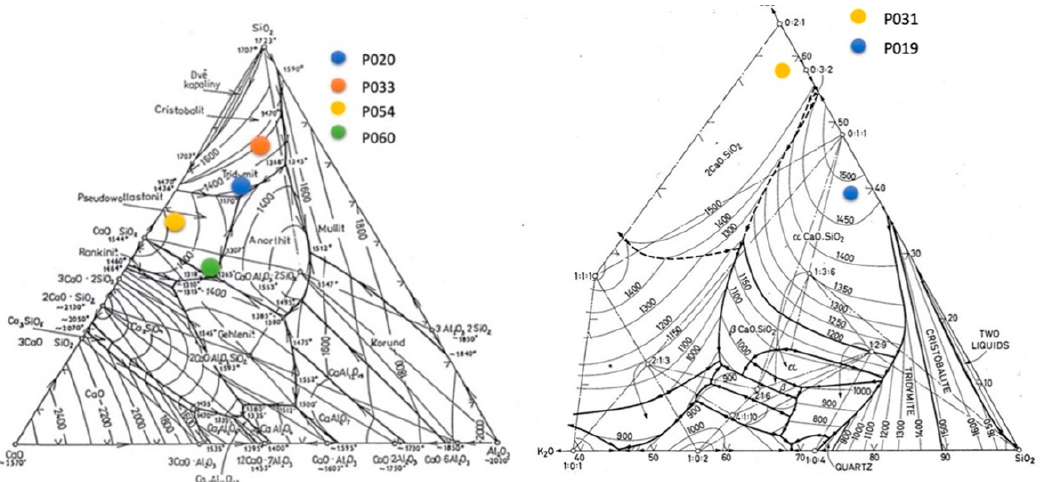
Figure 6. Approximate position of ash types P 020 , P 033 , P 059 , P 060 , in ternary diagram CaO–Al 2 O 3 –SiO 2 [27] and P 031 and P 019 in ternary diagram K 2 O–Al 2 O 3 –SiO 2 [28].